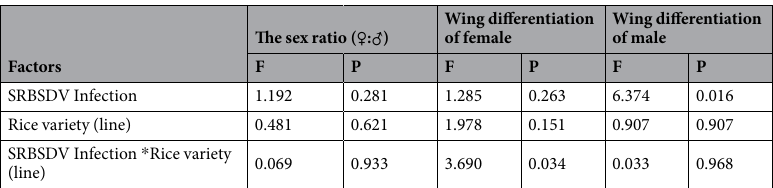
Table 6. ANOVA of effects of transgenic rice plants infected with SRBSDV on the sex ratio and wing differentiation of BPH.